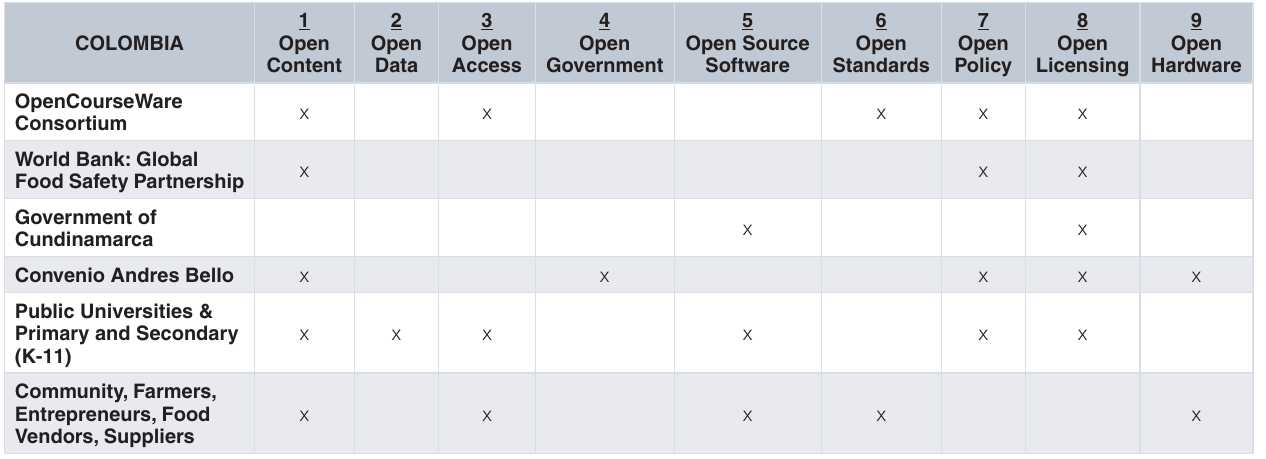
Table 2. Potential starting points for stakeholder use of open practices: